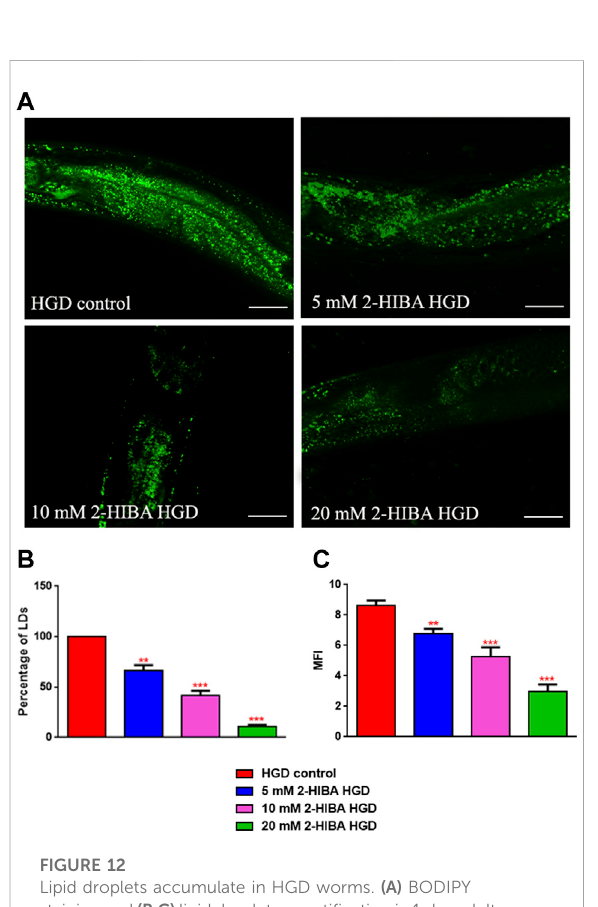
FIGURE 12 Lipid droplets accumulate in HGD worms. (A) BODIPY stainingand (B,C) lipiddropletsquanti fi cationin1 dayadultworms grown in the presence of glucose and fed with E. coli OP50 alone (control) or supplemented with different 2-HIBA concentrations (** p < 0.01, *** p < 0.001). Scale bar = 50 μ